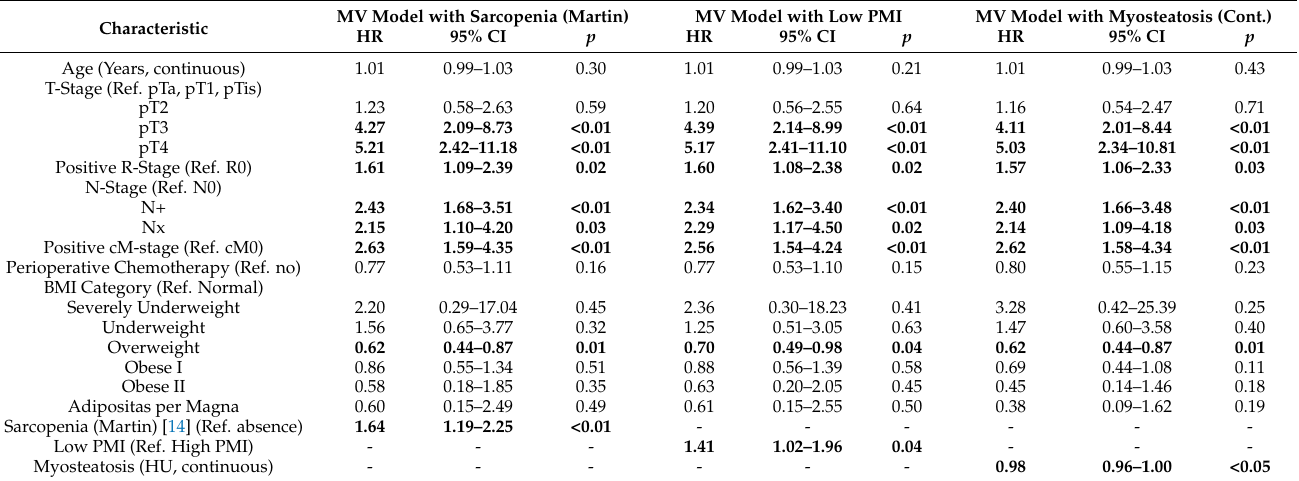
Table 5. Multivariate Cox-regression analyses for different body composition measurements for CSS in the 657 patients who underwent radical